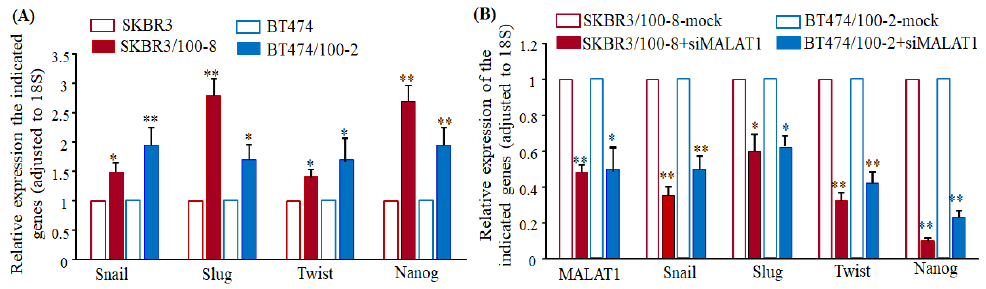
Figure 3. Cont. Figure 3.